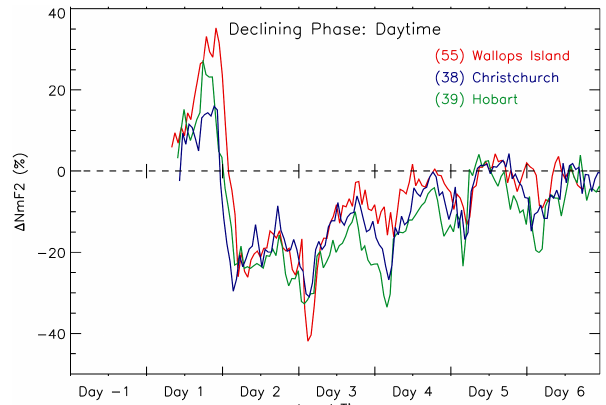
Fig. 8. Average storm patterns of 1 Nm F2(%) in local time for the subset of storms with daytime SCs that occurred during the declin- ing phase of solar cycle #20 (1971–1974). Results are shown for the three stations in Table 2 used to address small differences in geographic and geomagnetic latitudes (see